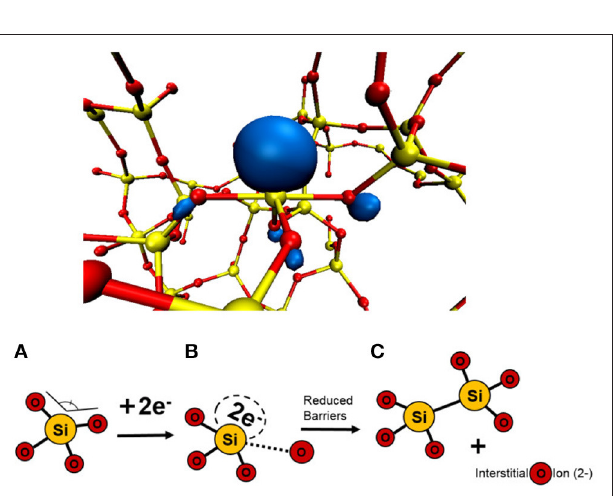
FIGURE 6 | Schematic illustrating how trapping of two electrons at a precursor site facilitates creation of neutral O vacancy and interstitial O 2 − ion [45]. (A) Wide angle intrinsic traps in the amorphous network can trap two electrons. (B) Trapped electrons on the precursor reduce the barrier for O interstitial to be displaced. (C) O 2 − ion is displaced to create a vacancy-ion